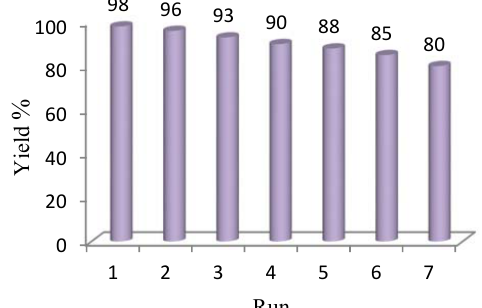
Run Fig. 5. Catalyst recovery at the end of the reaction in the model Figure 5. Catalyst recovery at the end of the reaction in the model reaction.